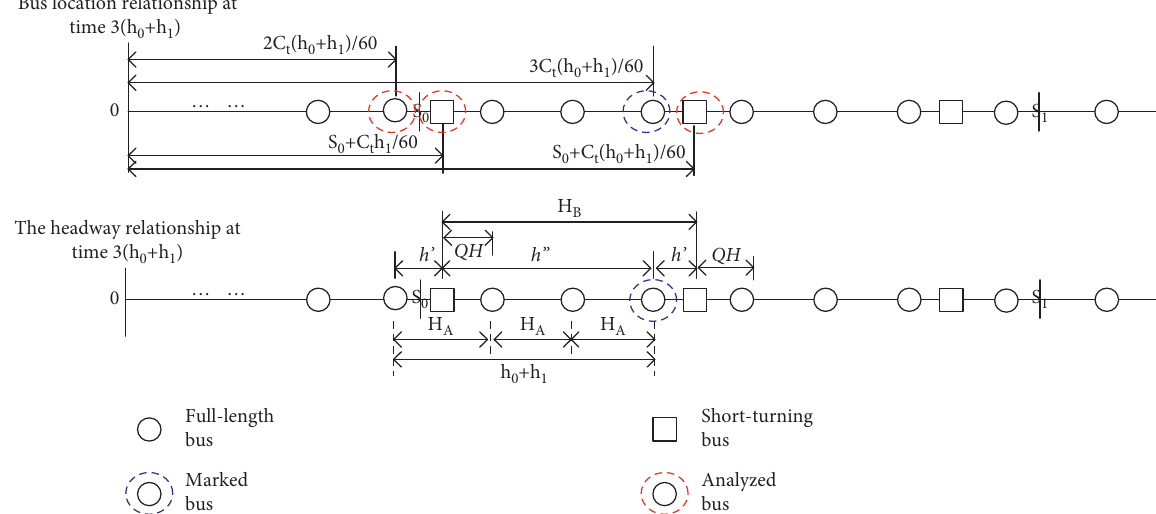
Figure 3: Schematic diagram of the departure frequency relationship between short-turning buses and full-length buses ( g �